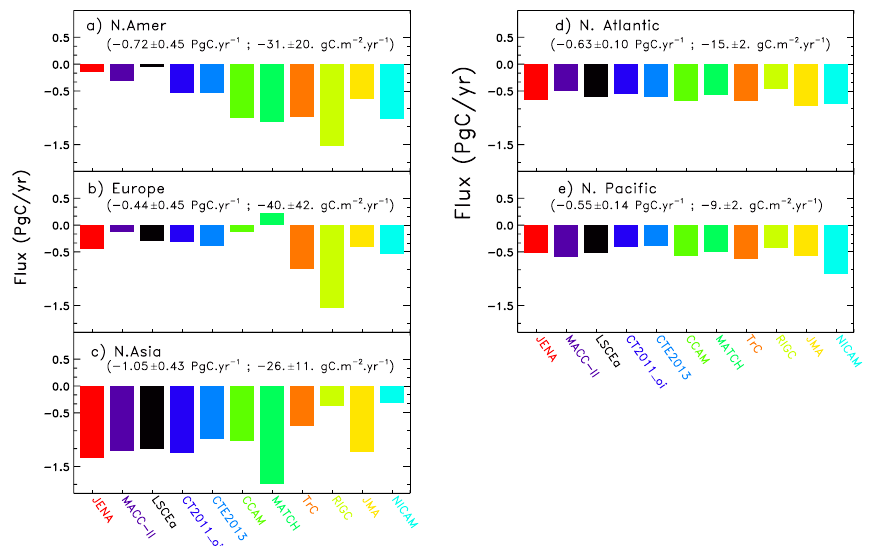
Fig. 5. Same as Fig. 4 but the breakdown of the Northern Hemisphere fluxes into (a) North America, (b) Europe, (c) North Asia, (d) N. At- lantic, and (e) N. Pacific. Numbers in parenthesis represent the mean flux and the standard deviation across all inversions.